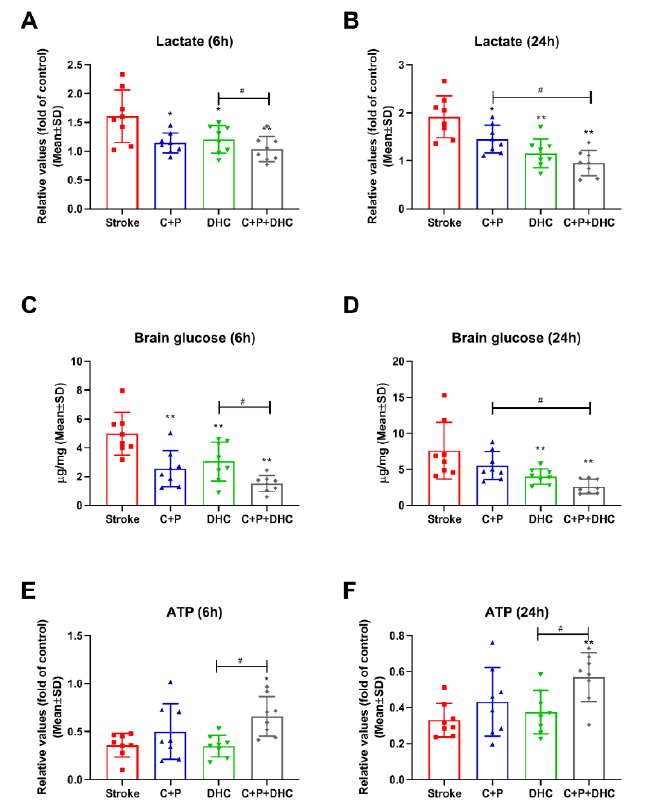
Figure 3. Effect of pharmacological hypothermia on lactate, glucose, and ATP levels in rats with 2 h MCAO. Lactate level was significantly increased after stroke, which was significantly reduced by C + P, DHC, or combination treatment at both 6 ( A ) and 24 h ( B ) after reperfusion. Brain glucose levels increased at 6 ( C ) and 24 h ( D ) of reperfusion. DHC or the combination of C + P and DHC decreased brain glucose level at both 6 and 24 h of reperfusion, while C + P decreased brain glucose level at 6 h of reperfusion. Stroke reduced ATP levels, and only the combination therapy significantly increased ATP levels at both 6 ( E ) and 24 h ( F ) after reperfusion. Data are presented as mean ± SD, * p < 0.05, ** p < 0.01, as compared to stroke group; # p < 0.05, as compared to C + P or DHC alone ( n =